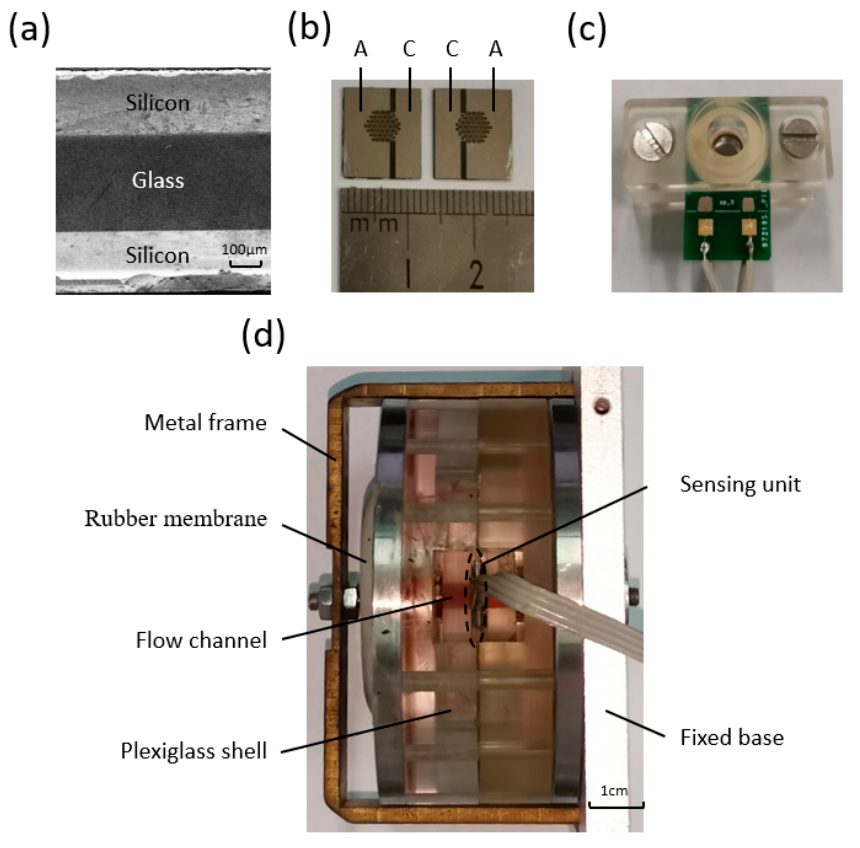
Figure 5. ( a ) Side view of the sensing unit, and assembly process of the electrochemical seismome- ter ( b – d ), including ( a ) both sides of the sensing unit, ( c ) the assembled sensing unit and ( d ) the electrochemical seismometer.